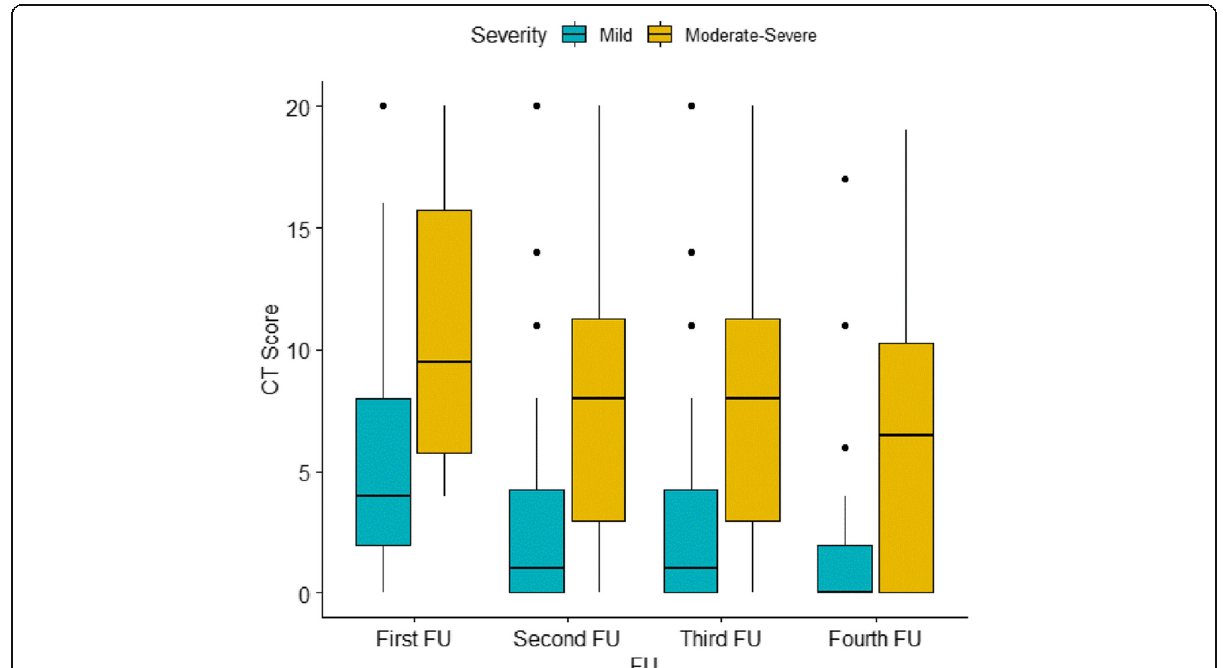
Fig. 4 The median chest CT score was plotted against the 1-month follow-up period for mild and moderate to severe COVID-19 patients